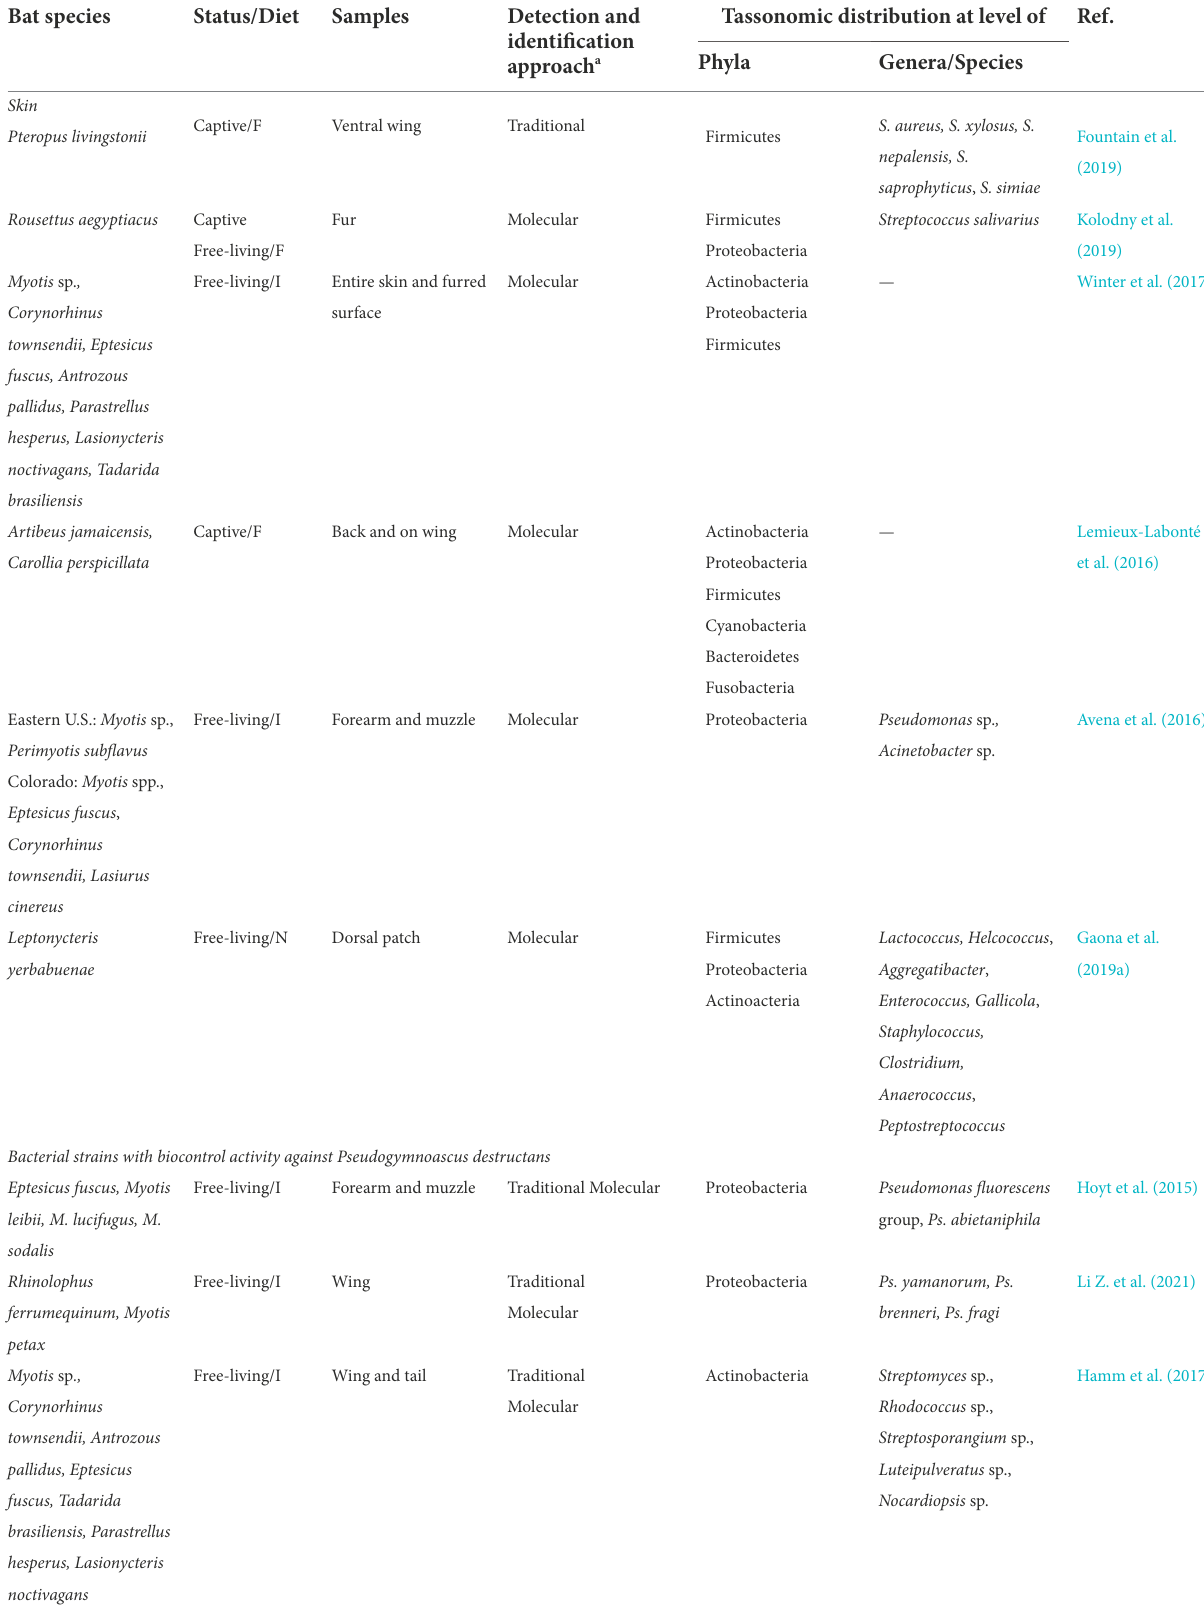
TABLE 1 Taxonomic distribution of commonly widespread bacteria in various body